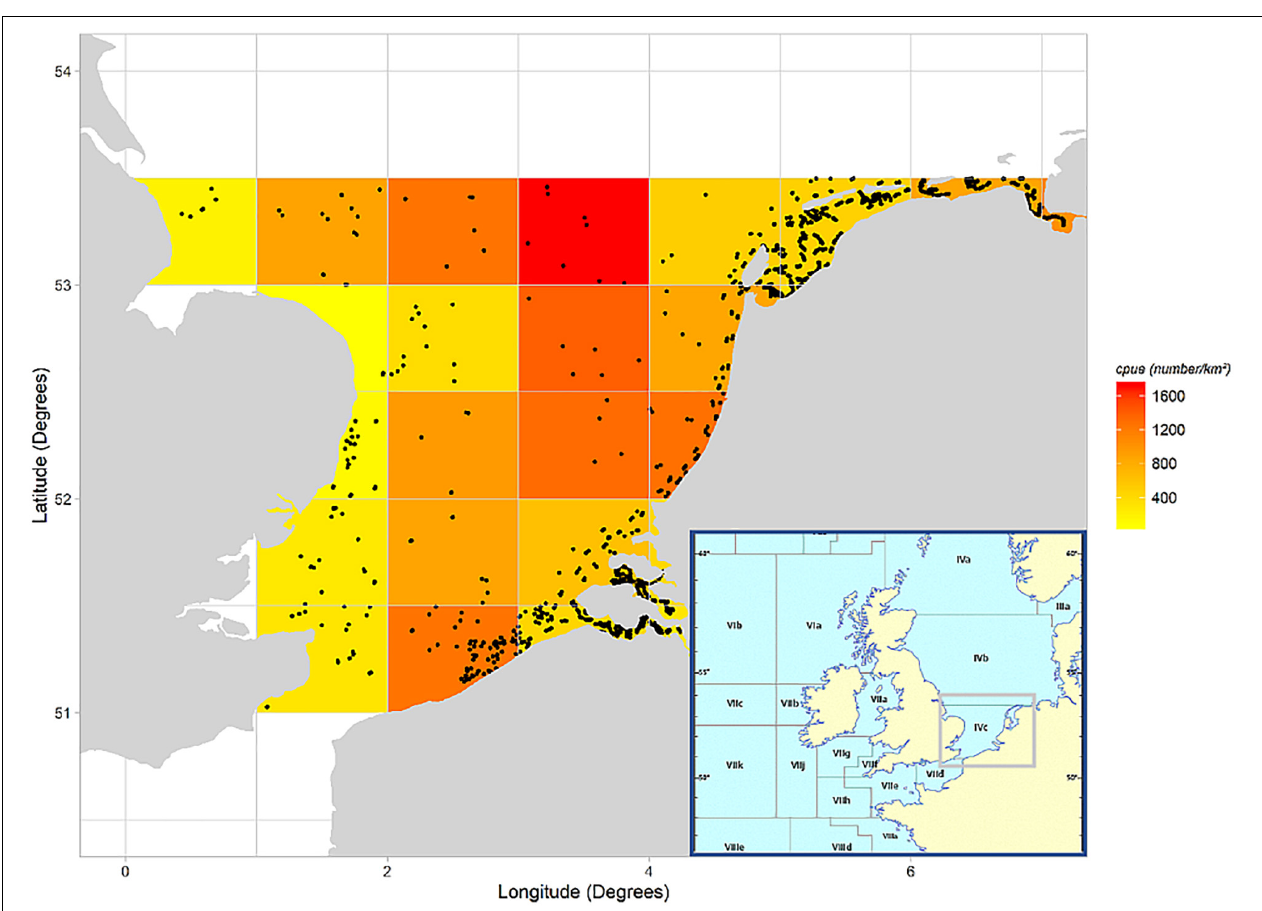
FIGURE 4 | Distribution of plaice ( Pleuronectes platessa ) in the southern North Sea, based on beam trawl surveys (BTS and DYFS) from 2010 to 2019. The colour shading yellow, orange, and red represent low, medium, and high average CPUEs (numbers/km 2 ), respectively. Black dots depict sampling positions. CPUE, catch per unit